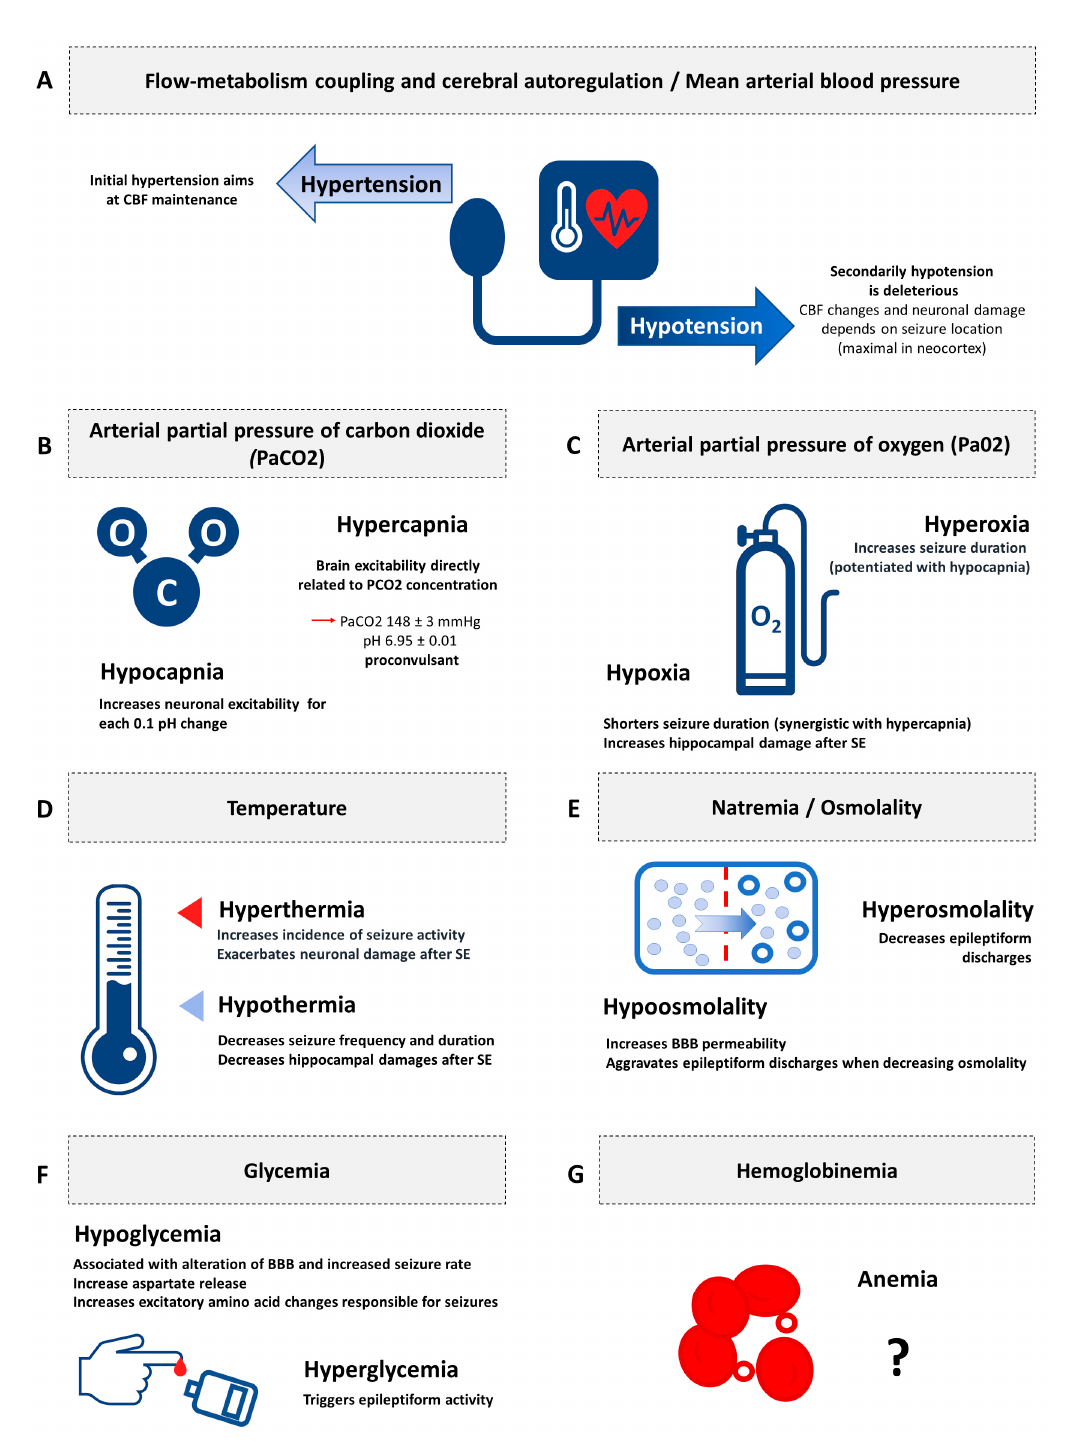
Figure 2. Synthesis of the evidence of secondary brain insults in experimental status epilepticus. CBF: cerebral blood flow; PaCO 2 : arterial partial pressure of carbon dioxide; PaO 2 : arterial partial pressure of oxygen; BBB: blood brain barrier. ( A ) Flow-metabolism coupling and cerebral autoregulation / Mean arterial blood pressure; ( B ) Arterial partial pressure of carbon dioxide (PaCO2); ( C ) Arterial partial pressure of oxygen (Pa02); ( D ) Temperature; ( E ) Natremia / Osmolality; ( F ) Glycemia; ( G )